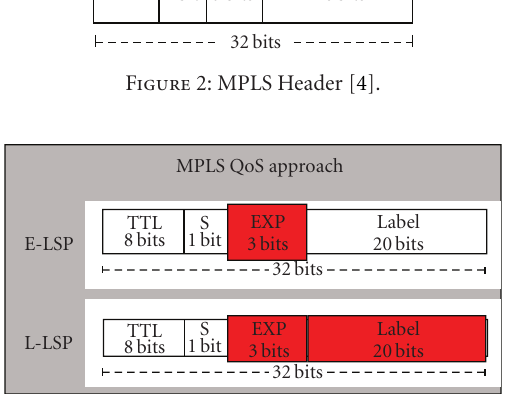
Figure 3: MPLS QoS-based Label